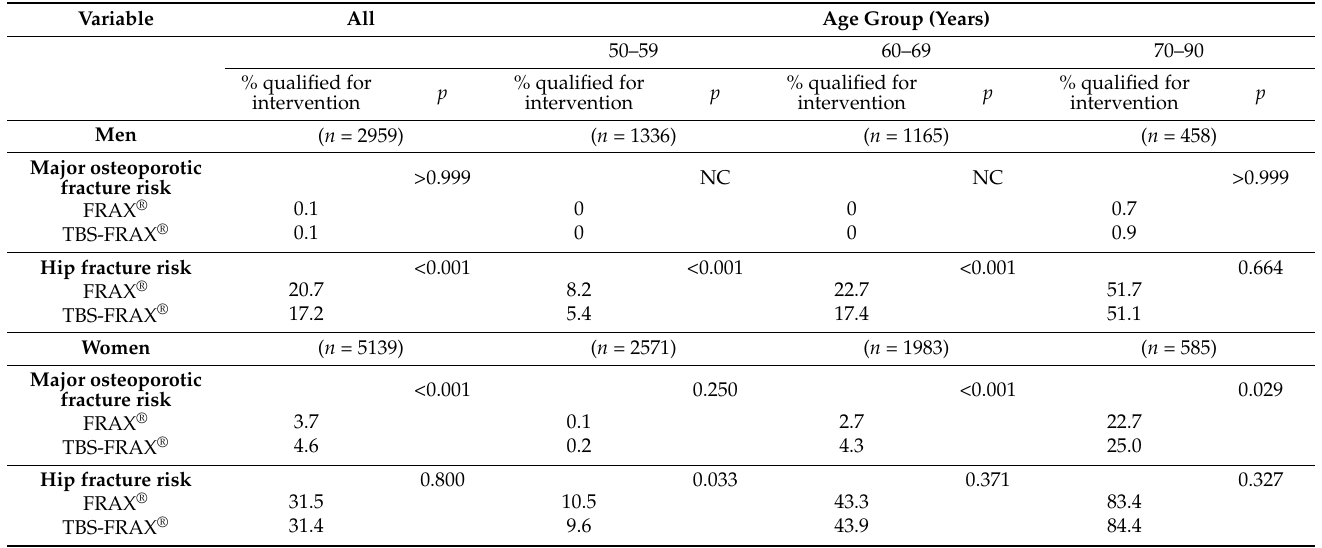
Table 2. The proportions of men and women at high risk of major osteoporotic fracture ( ≥ 20%) and hip fracture ( ≥ 3%) according to the FRAX ® and TBS-FRAX ® , with stratification by age